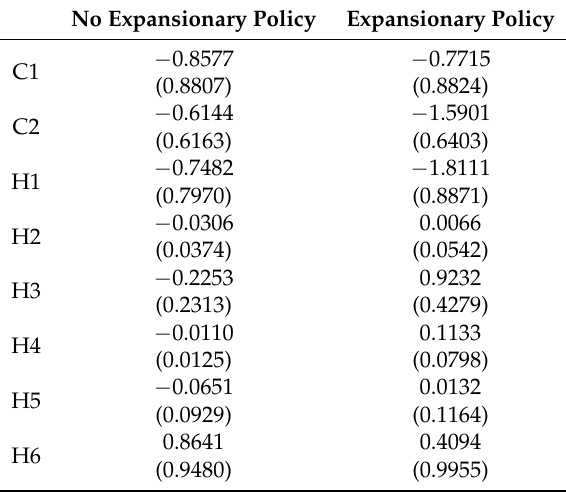
Figure 3. Effects of EPU shock on consumption and working hours. Table 4. Effects of EPU shock on household